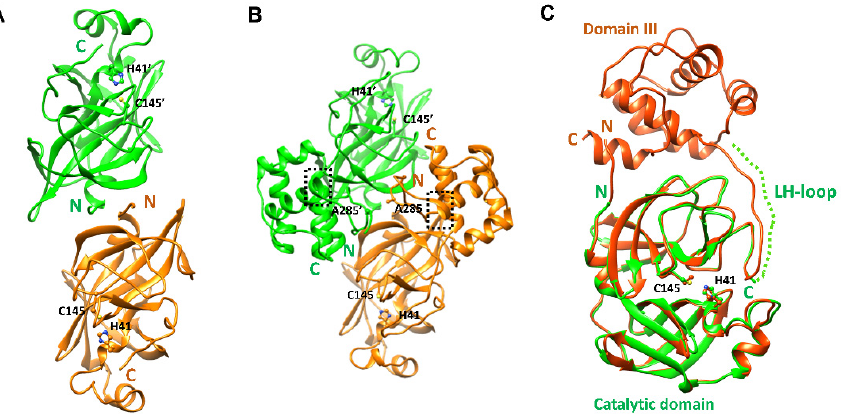
Figure 1. The X-ray crystal structure of the catalytic domain of SARS-CoV-2 3CLpro compared with the model structure. Each subunit is colored differently. Active site residues are drawn with a ball-and-stick model. N- and C-terminals are labeled. ( A ) The X-ray crystal structure of the catalytic domain of SARS-CoV-2. ( B ) The crystal structure of the entire SARS-CoV-2 3CLpro (7K0F). Ala285 residue on the DM-loop was depicted. The dotted boxes represent the last turn of helix α 7. ( C ) The superposition of both monomeric forms. The LH-loop is displayed with a dotted line. Table 1. Data collection statistics and refinement parameters for the catalytic domain of SARS-CoV- 2 3CLpro.